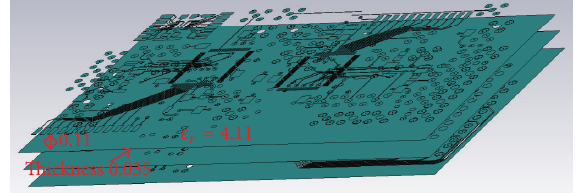
Figure 10: PCB dimensional structure.